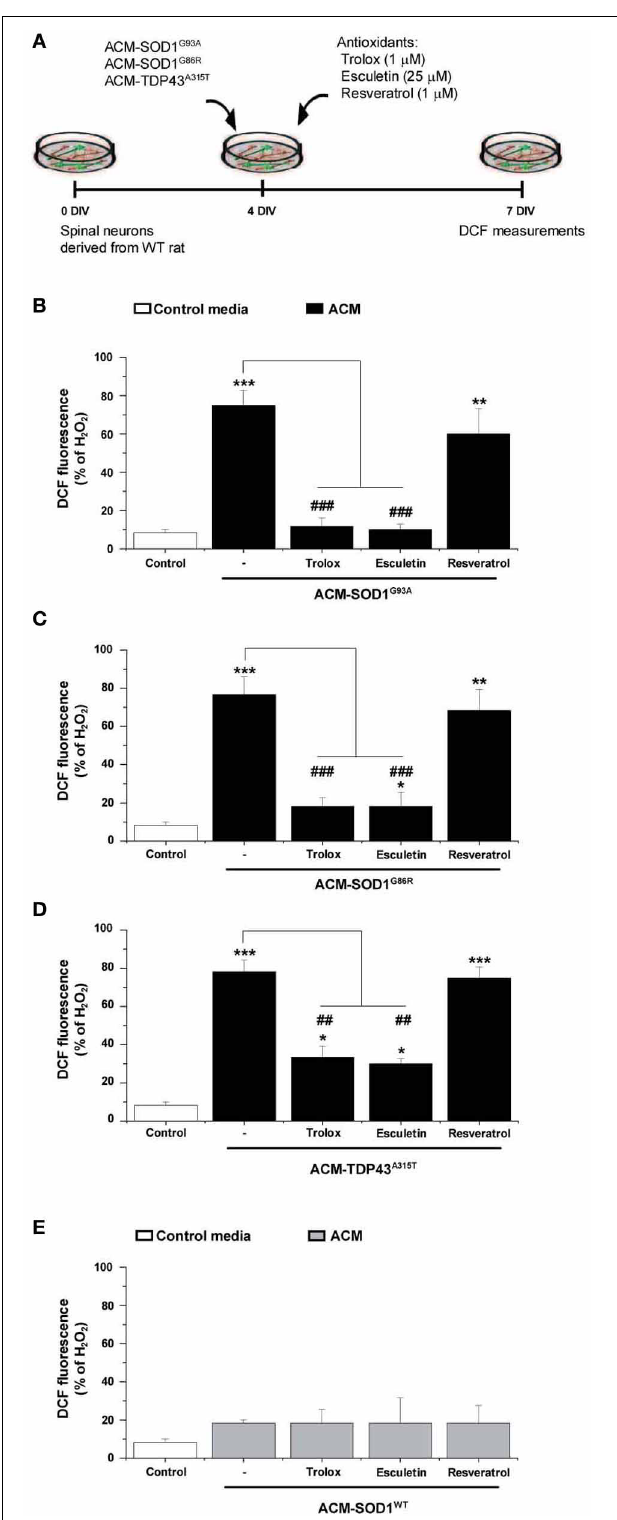
FIGURE 4 | The effect of anti-oxidants on DCF fluorescence in spinal cord cultures exposed to the diverse ACMs. (A) Flow diagram of experiment. ACMs were applied chronically starting at 4DIV alone, or